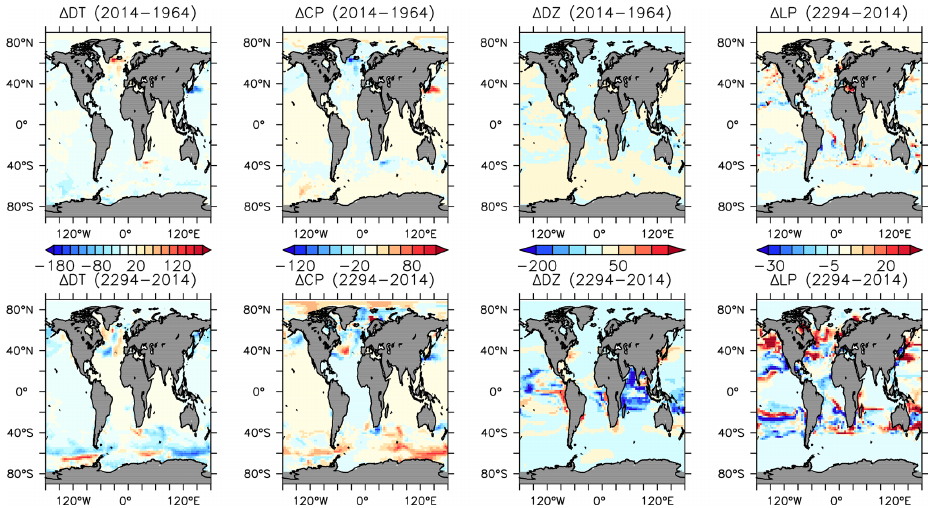
Figure 19. Modelled changes in phytoplankton biomass (mmolCm − 3 ) from 1964 to 2014 (top row) and from 2014 to 2294 (bottom